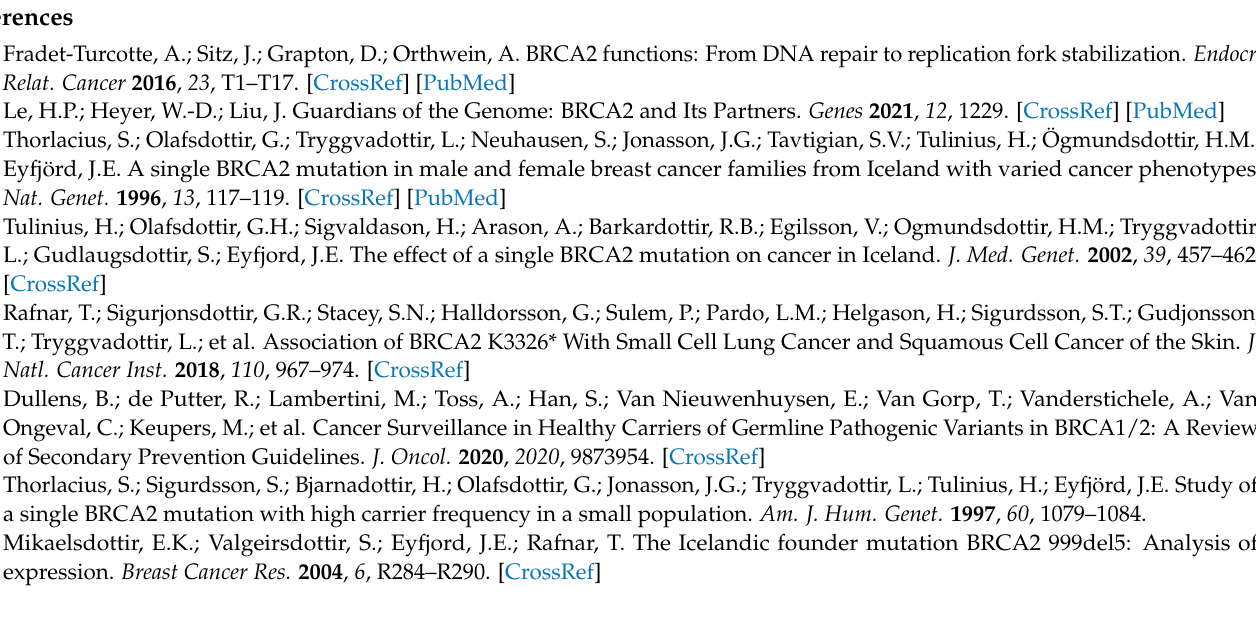
Table S2: Analysis of telomere free ends (TFE), Table S3: Telomere loss (TL) as a combination of STE and TFE, Table S4: Analysis of multitelomere signals on single sister chromatids (SMTS), Table S5: Analysis of multitelomere signals on both (double) sister chromatids (DMTS), Table S6: